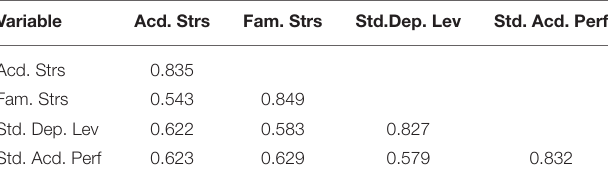
TABLE 3 | Discriminant validity